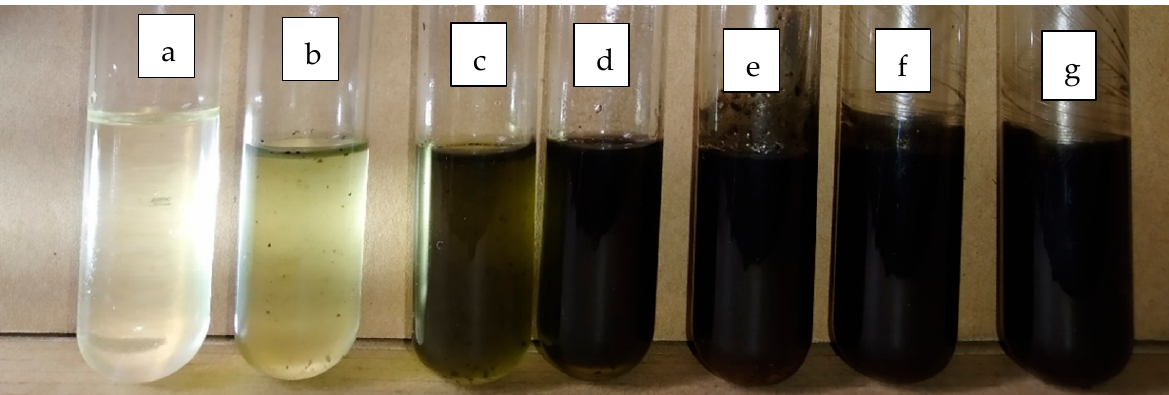
Figure 5. Microscopic images of ( a ) conidia suspension in water, ( b ) emulsion blank, and ( c ) emulsion-formulated conidia, at 400× magnification.